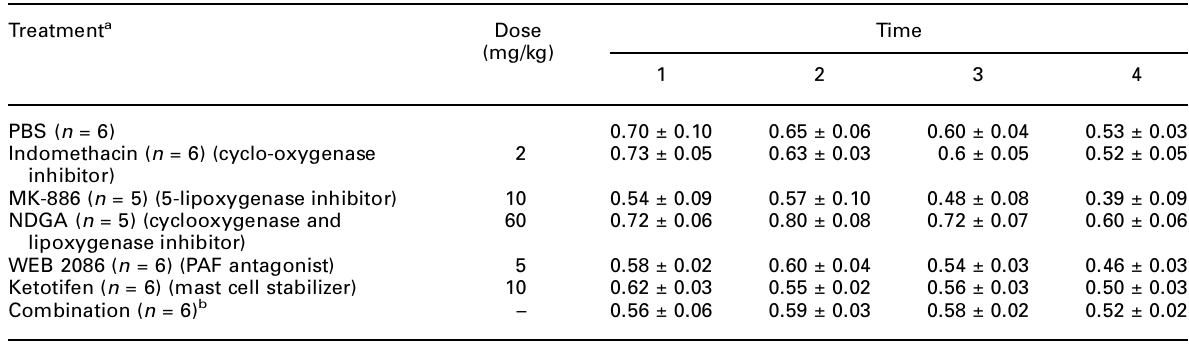
Table 1. Failure of standard agents to inhibit paw oedema induced by OVA in sensitized rats Treatment a